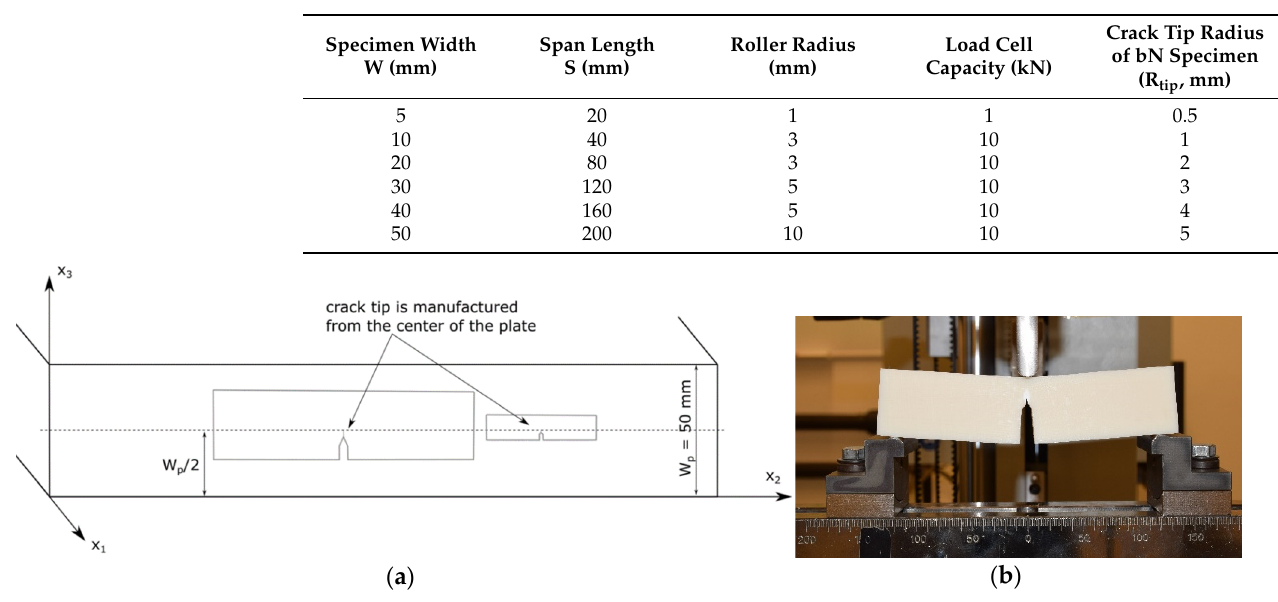
Table 1. Detailed information on the experimental setup and the crack tip radius of the bN specimen for all specimen sizes examined.